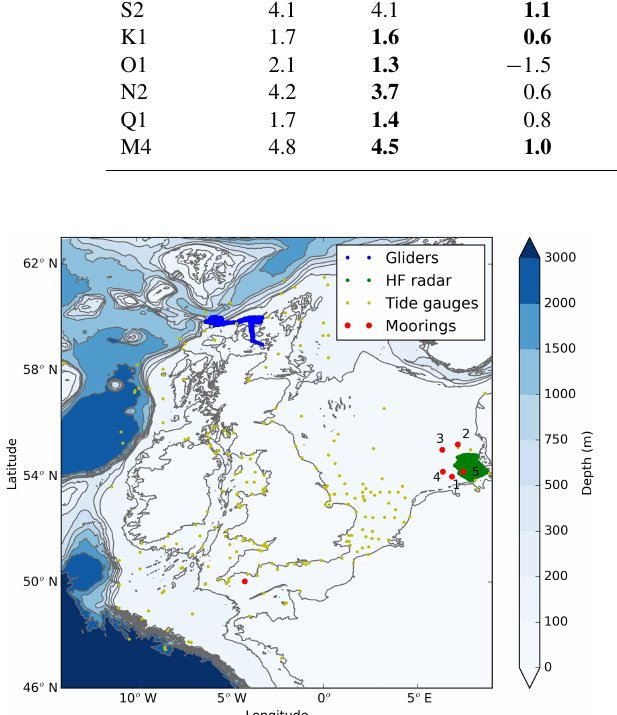
Figure 5. Maps of the independent observations used for validation. MASSMO4 gliders are blue, COSYNA HF radar in the German Bight in green, the mooring in the German Bight in red, and the tide gauges in